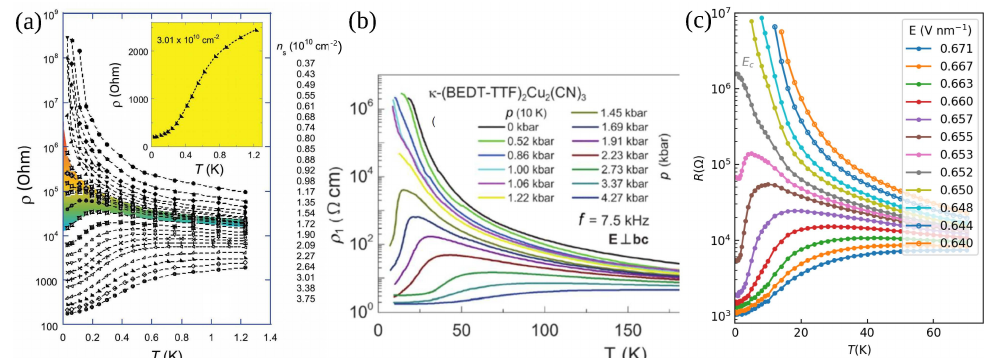
Figure 1. The key observable revealing a metal-insulator transition is the resistivity. Here we show ρ vs. T resistivity curves as a function the tuning parameter, for representative examples of the three material systems considered: ( a ) 2DEG in Si-MOSFET tuned by electronic density (reprinted with permission from Ref. [19] Copyright 2019 American Physical Society), ( b ) Mott organic material κ -(BEDT-TTF) 2 Cu 2 (CN) 3 tuned by pressure [20], and ( c ) TMD moiré bilayer MoTe 2 /WSe 2 tuned by displacement field (Data imported from [21]). In all cases, one observes distinct resistivity maxima on the metallic side, at a temperature T max that decreases towards the transition.